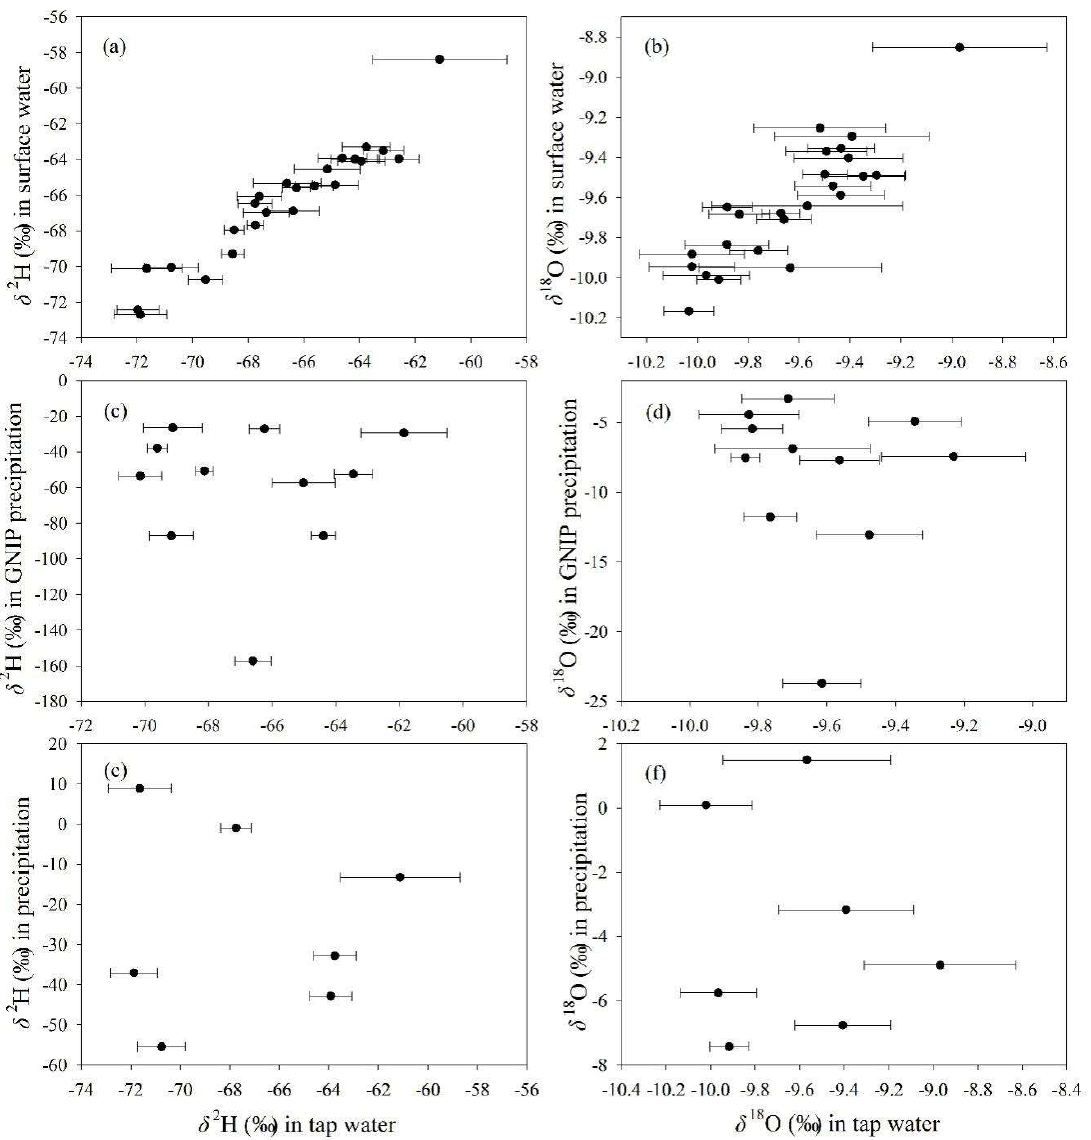
Figure 11. Relationship of δ 2 H and δ 18 O in surface water ( a , b ), GNIP precipitation ( c , d ) and collected precipitation ( e , f ) with those in tap water in Lanzhou. Solid circles and error bars show the arithmetic average and standard deviation, respectively. The monthly data of δ 2 H and δ 18 O in surface water and tap water at 7 sampling sites from March 2016 to February 2018 were used in ( a ) and ( b ). The monthly mean values of δ 2 H and δ 18 O in GNIP precipitation at the site of Lanzhou from 1985 to 1999 (the monthly mean values of δ 2 H and δ 18 O in February were absent) and those in tap water at 7 sampling sites from March 2016 to February 2018 were used in ( c ) and ( d ). The data of δ 2 H and δ 18 O in collected precipitation at the site of Qiujiawan and tap water at 7 sampling sites from April 2016 to October 2016 were applied in ( e ) and ( f ).